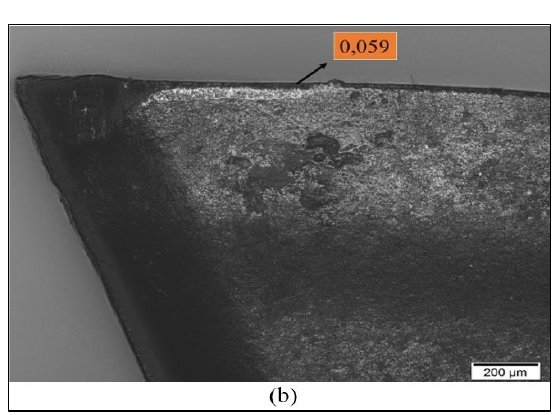
Figure 4b: Wear on the main flank with insert 0,4 mm: (b) With sealant.